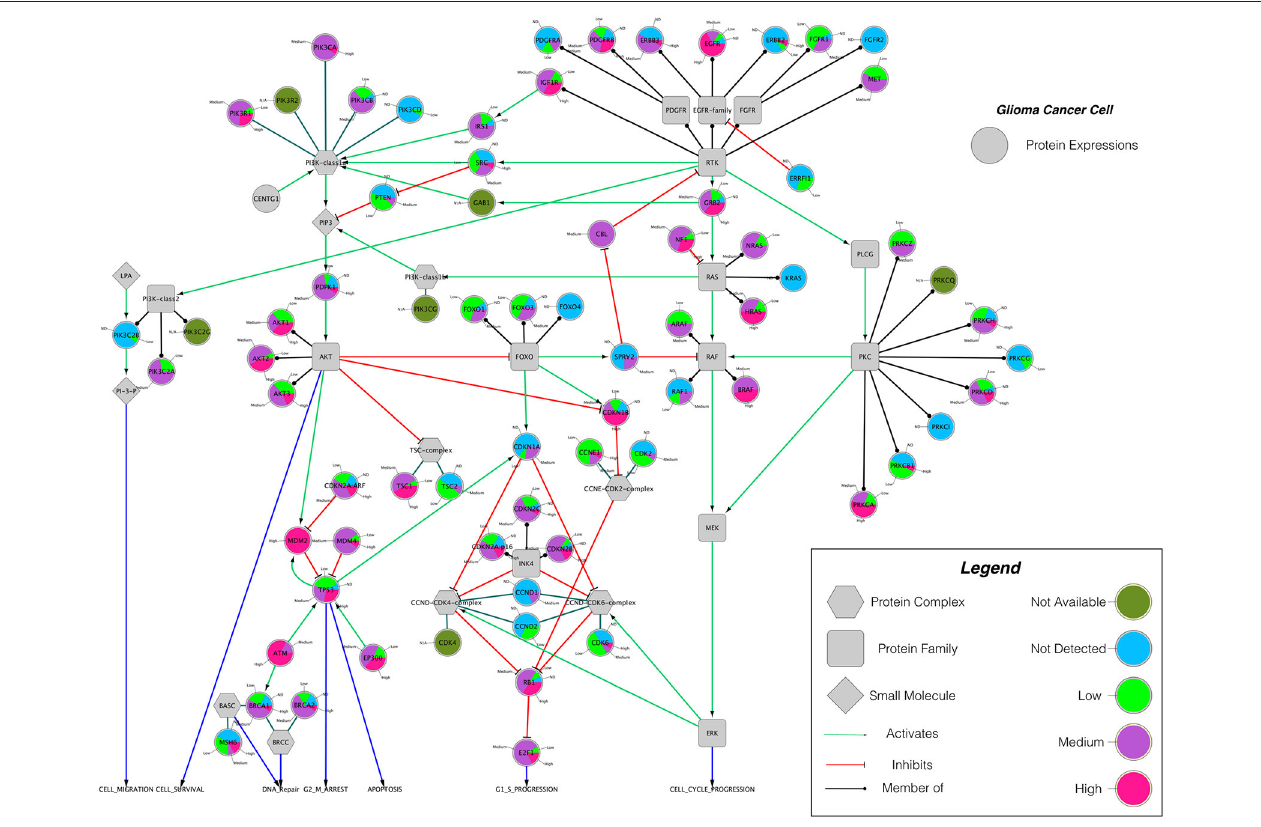
FIGURE 4 | The protein expression levels of glioma cancer cells mapped onto the GBM pathway map from the TCGA data set. In this diagram, The Human Protein Atlas database were used to obtain protein expression levels of glioma cancer cells. Special shapes used in the map represent different types of molecules which are given in the legend of the figure as protein complex, protein family, protein and small molecule, respectively. Lines and arrows show the relationship of the molecules. Each protein symbol (circle) is shown as pie chart to represent different expression levels of glioma cancer cell which are depicted in different colors. Olive for not available, deep sky blue for not detected, green for low expression, medium orchid for medium expression, and deep pink for high expression. The original GBM pathway map in the Cytoscape format was downloaded from (“The Cancer Genomics at cBio—Glioblastoma (TCGA)” n.d.).